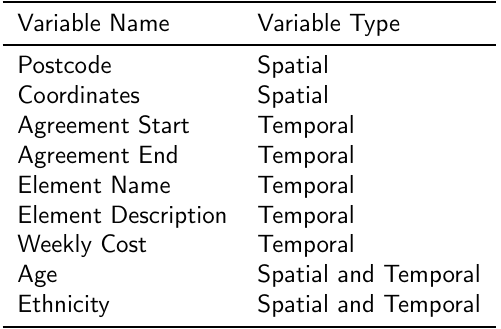
Table 4: The CareFirst data records utilised in subsequent case studies in this paper.